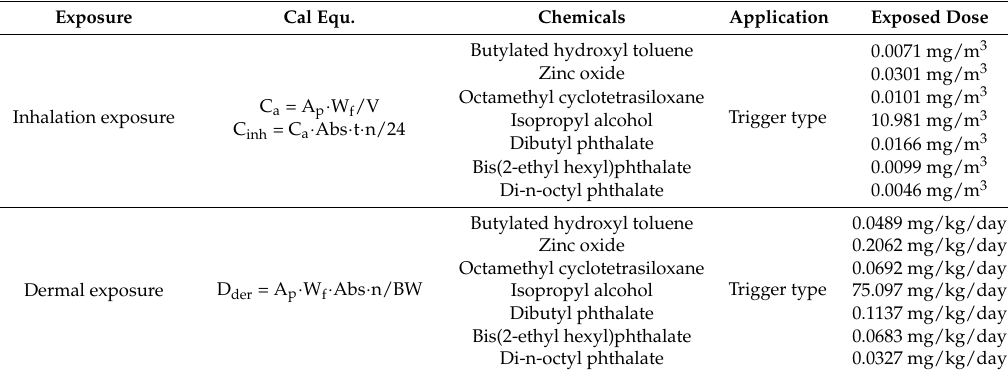
Table 5. Scenarios for the exposure and calculation of inhalation and dermal exposed dose. Exposure Cal Equ.